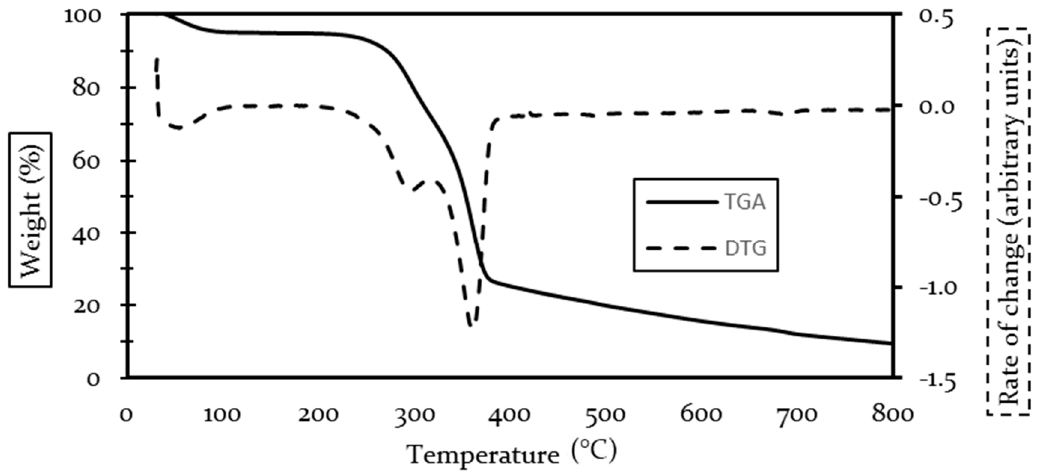
Figure 2. TGA and DTG curves for fique fibers.